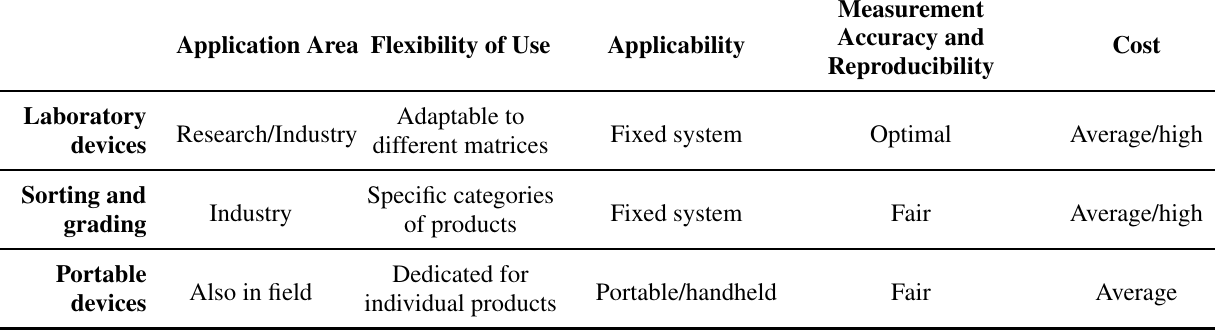
Table 1. Characteristics of the three main categories of NIR